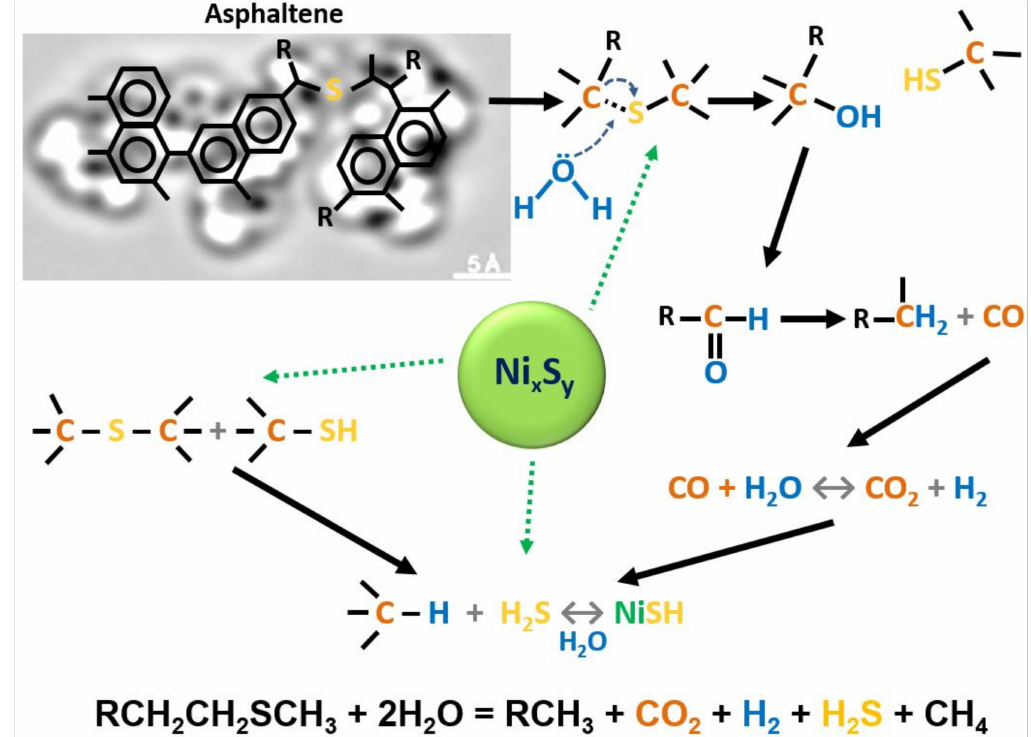
Figure 1. The schematics of main chemical reactions during the aquathermolysis process in the presence of nickel sulfide